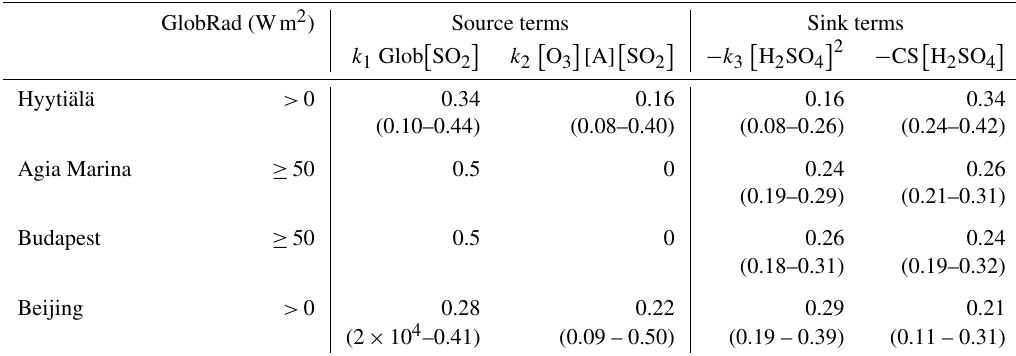
Figure 11. Fraction contribution of each source and sink term to the change in H 2 SO 4 concentration. Figure 11 is complementary to Table 3. The boreal, rural, urban and megacity labels refer to the Hyytiälä, Agia Marina, Budapest and Beijing sites, respectively. Note that the fraction of the alkene term contribution is not zero for the rural or urban sites but is due to unavailable alkene data from these sites. In (a) we show all day medians for Hyytiälä and Beijing, and in (b) we show daytime medians for all sites. Table 3. Fraction of each source and sink term for the change in H 2 SO 4 concentration. Median of bootstrap resampling results and their 25th and 75th percentiles are